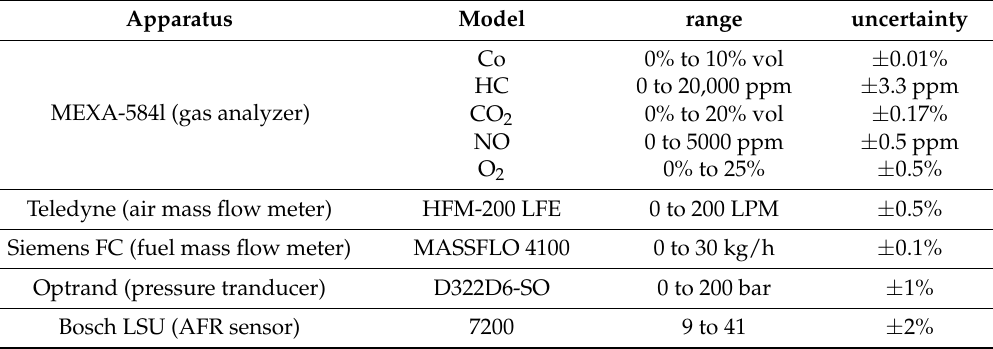
Figure 3. Single-cylinder engine model.